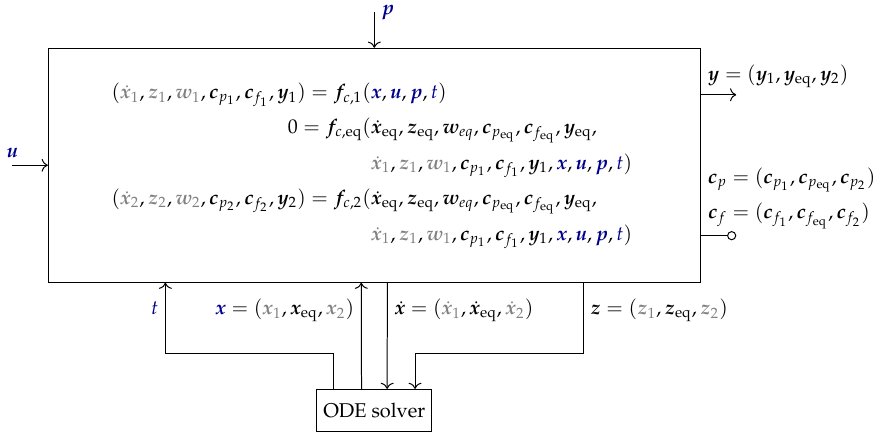
Figure 2. Mathematical description of an acausal component with pre-translated functions with the same interface as in Figure 1. These components can be connected via u , y , c p , c f . Arguments given in grey will be moved into an internal memory in Section 3.3. f c ,1 , f c ,2 are explicit functions, whereas 0 = f c ,eq ( . . . ) is a set of implicit equations. Variables ˙ x , z , w , c p , c f , y are unknown and are split into three parts, e.g., y = ( y 1 , y eq , y 2 ) , where y 1 is an output argument of function f c ,1 , y eq is computed from the implicit equation system 0 = f c ,eq ( . . . ) , and y 2 is an output argument of function f c ,2 .